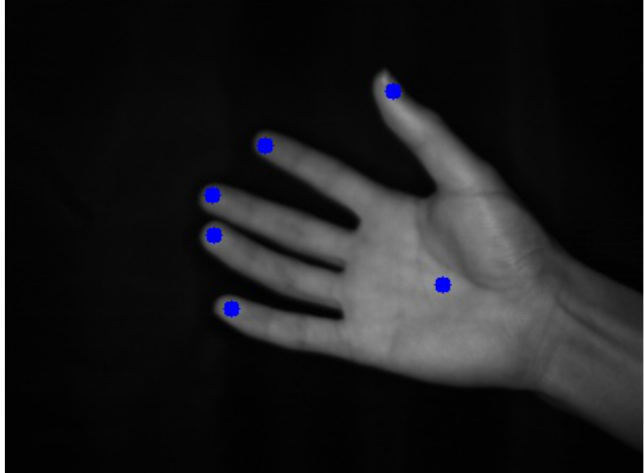
Figure 3. Annotation result of fingertip